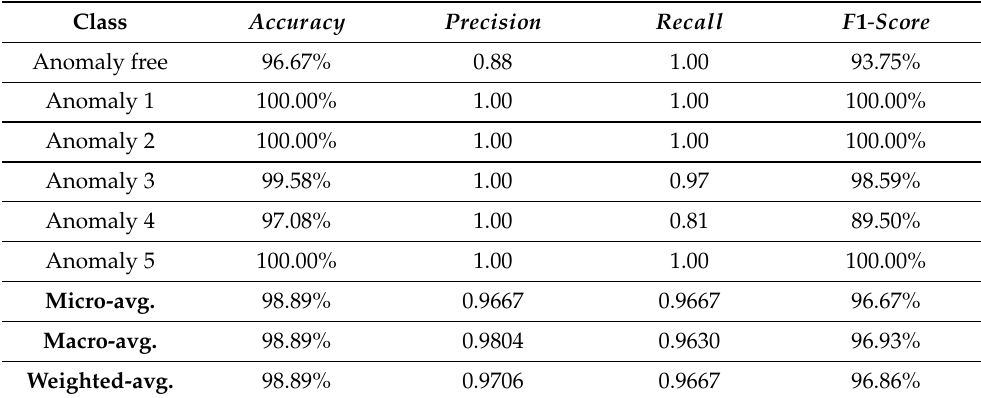
Table 3. Performance metrics of WM-ANN.